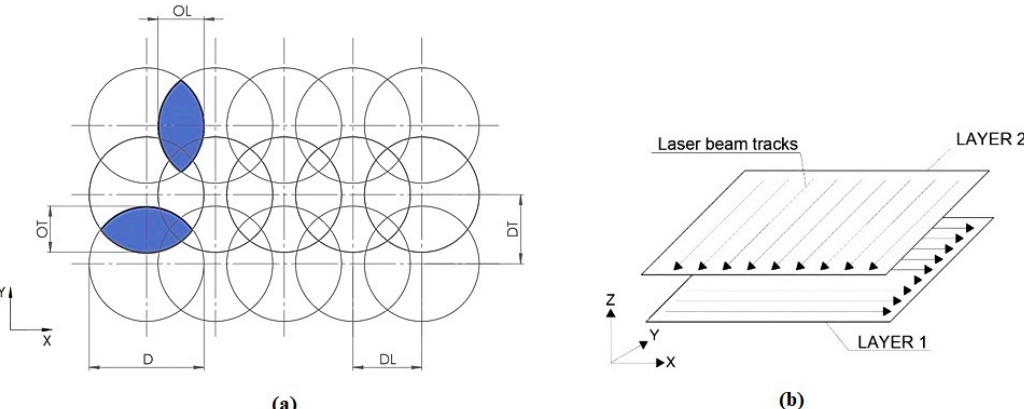
Figure 3. Scheme of the laser beam micromachining motion strategy. ( a ) scheme of pulses overlaps, where D is diameter of laser spots, D L is lateral pulse distance, D T is transverse pulse distance, O L is lateral overlap and O T is transverse overlap; ( b ) scheme of ablated layers. Table 1. Input process parameters of the laser-beam micromachining.